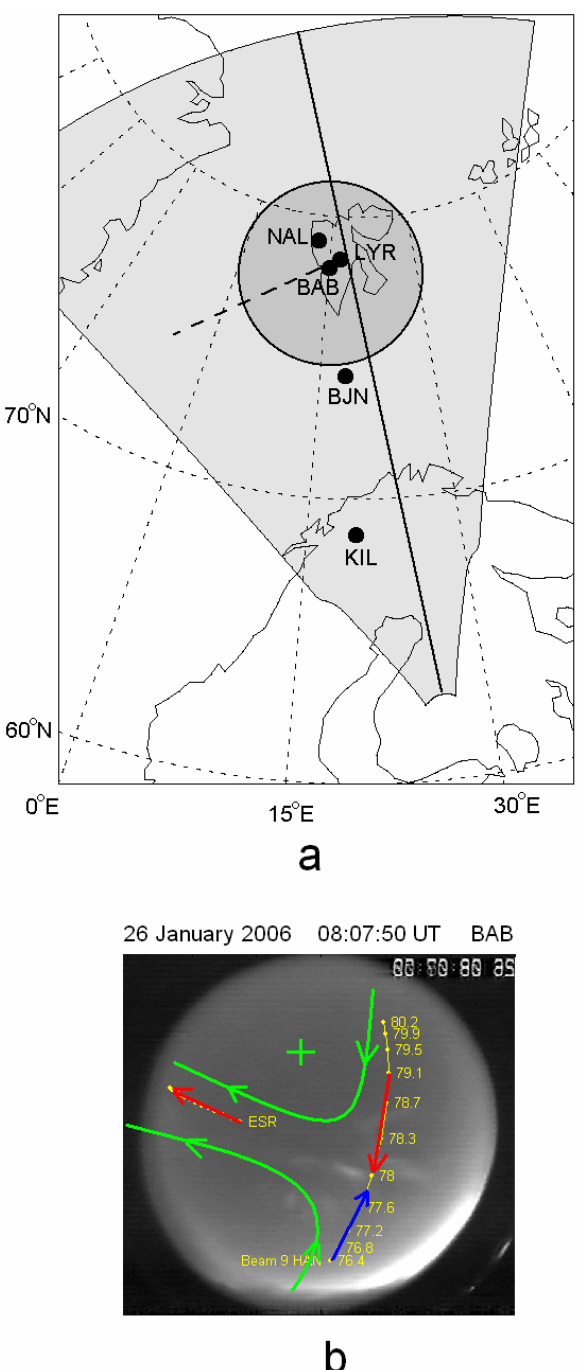
Fig. 4. (a) Location of the instruments in the region of observations; (b) optical auroras and ionospheric convection model (green curves) inferred from EISCAT and CUTLASS measurements shown with red and blue arrows. The green cross is the supposed position of the focus of the high latitude reverse cell.